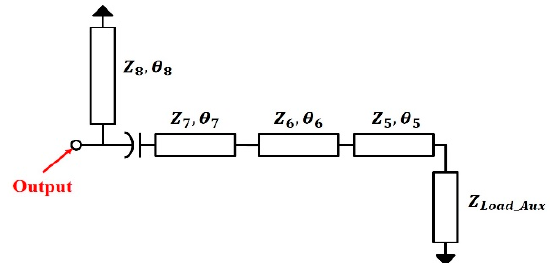
Figure 12. Auxiliary Amplifier portion of the output combiner.